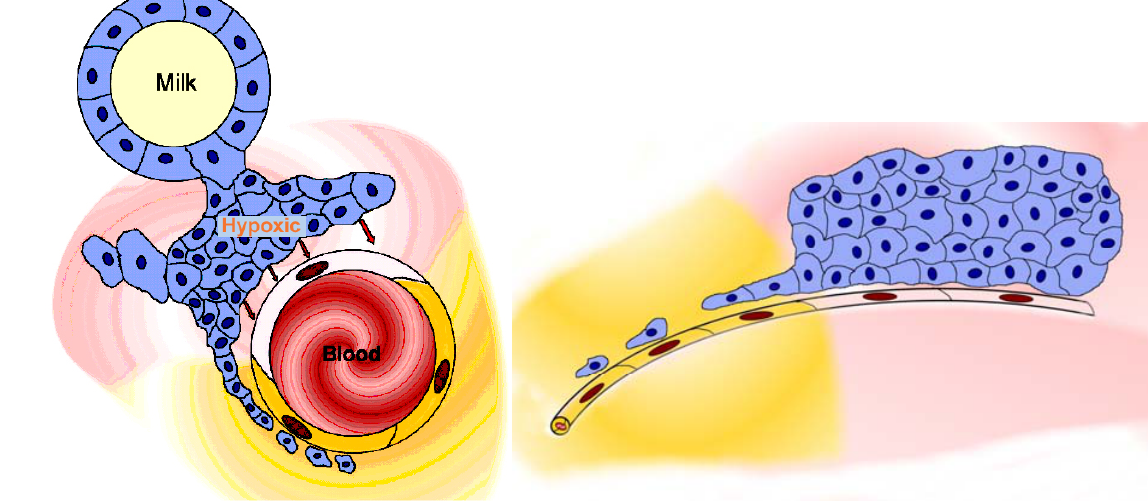
filiae, resulting in the relatively high mortality due to metastasis that is associated with breast cancer. These are the cells which must be accessed via transbarrier targeting, see Figure